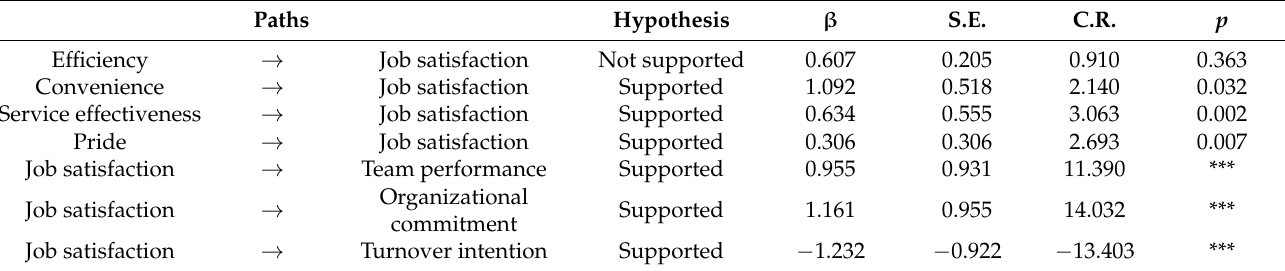
Table 5. Scandalized Parameter Estimates for Structural Model.